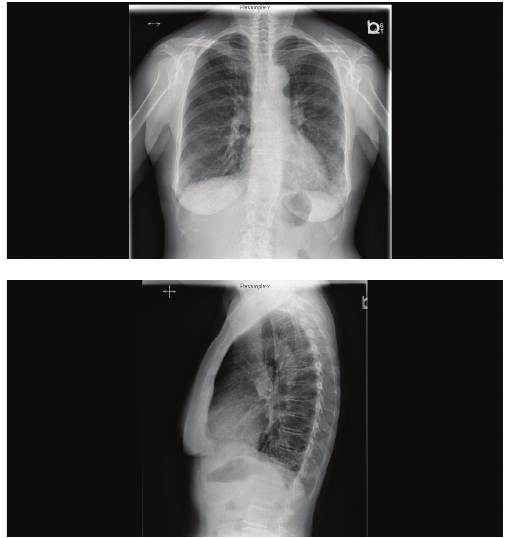
Figure 1: Posteroanterior and lateral chest X-ray revealing bilateral reticular infiltrates seen more significantly in the lower lung zones.